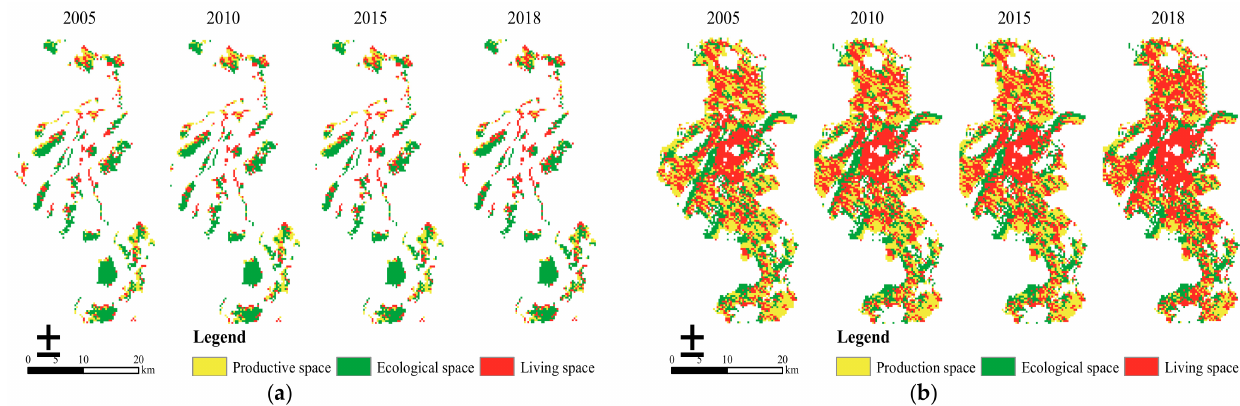
Figure 3. ( a ) Spatial distribution of PLES in ecological redline areas during 2005–2018; ( b ) spatial distribution of PLES in non-ecological redline areas during